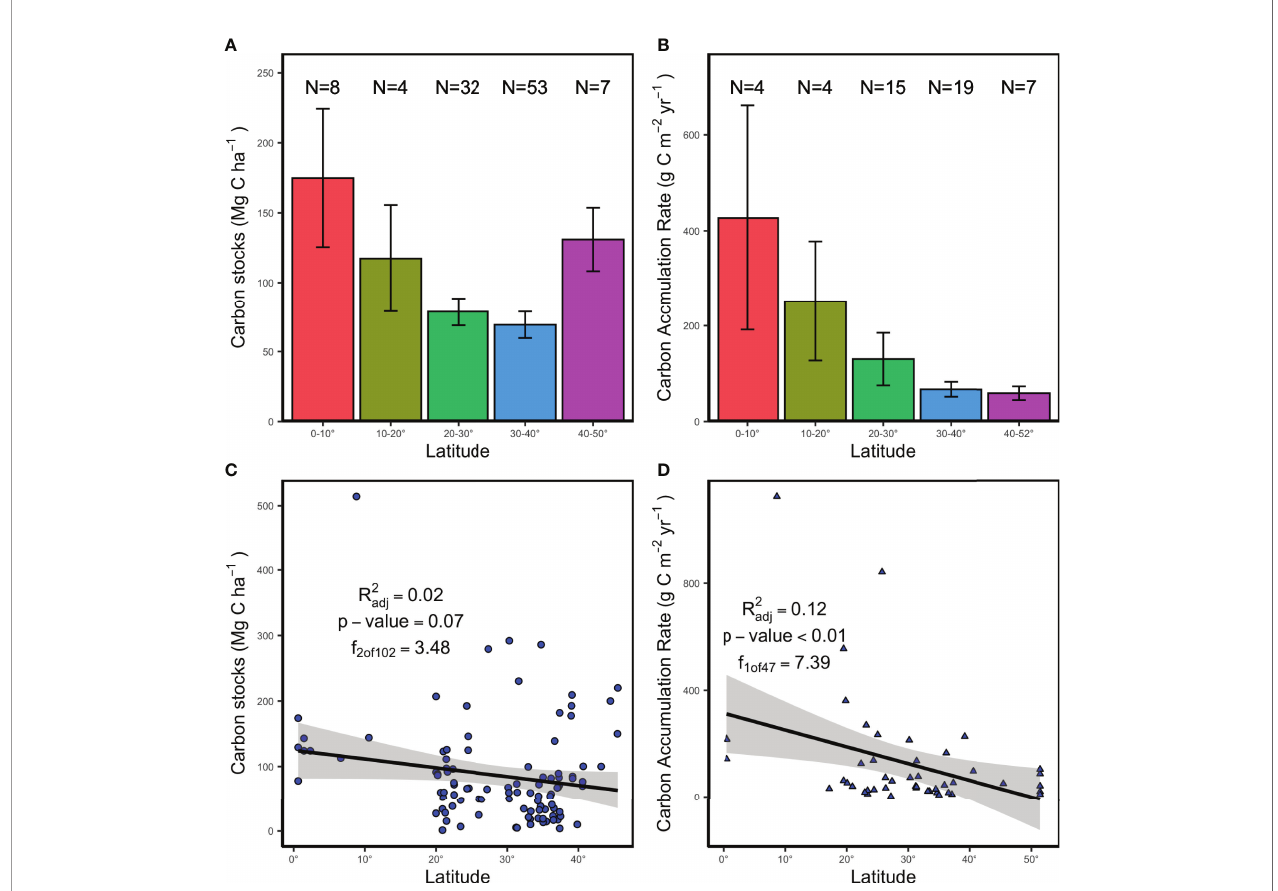
FIGURE 4 | Latitudinal variation of sediment C sequestrations in tidal fl ats. Latitudinal comparison of sediment C stock (mean ± SE) and CAR (mean ± SE) are shown in (A, B) , respectively. The solid line and the shadow area in (C, D) represent the best fi tting line and 95% CI,